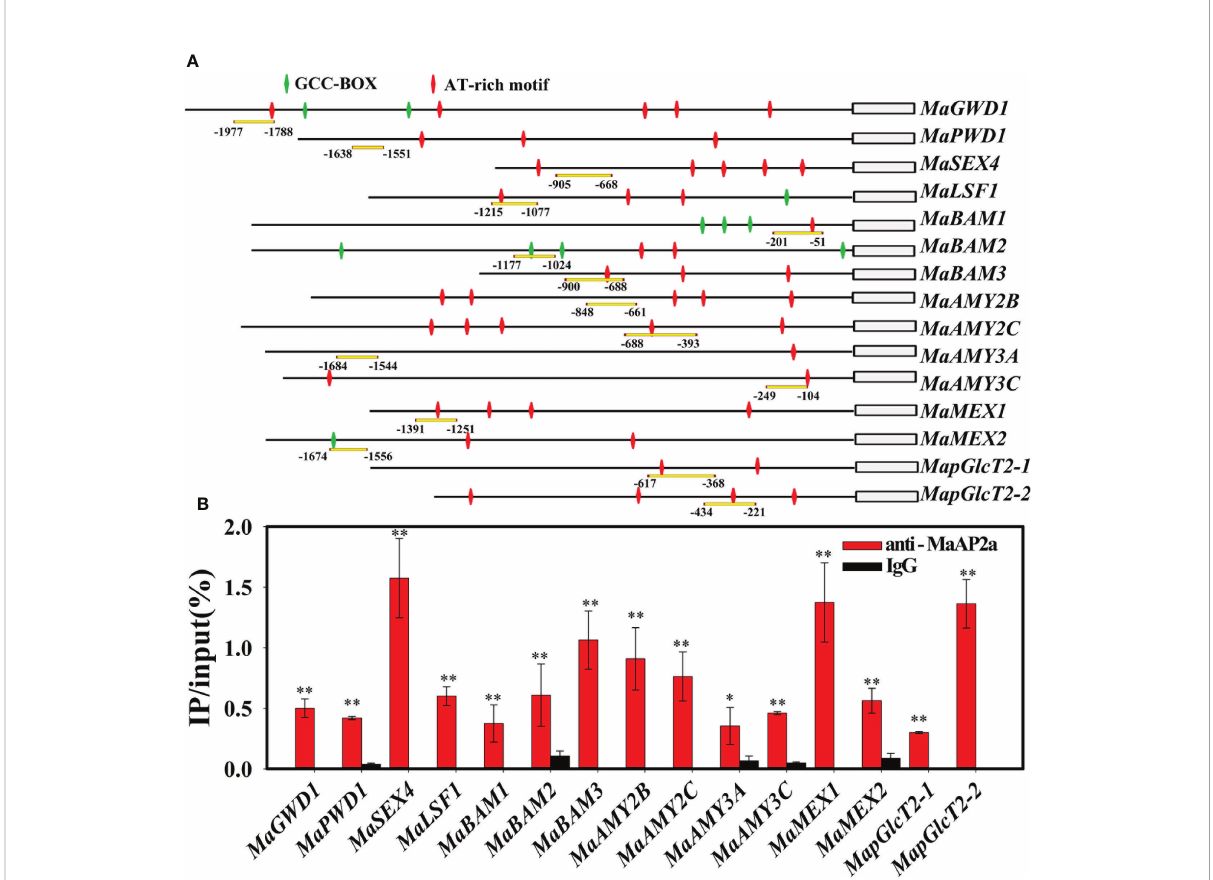
FIGURE 6 MaAP2a binds to the promoters of genes involved in starch degradation in vivo . (A) Schematic representation of selected regions for ChIP-qPCR analyses. Probes selected for the qPCR assay are indicated with yellow underline. GCC-box and AT-rich motifs of the promoters are indicated with green and red diamonds, respectively. (B) ChIP-qPCR assay showing the binding of MaAP2a to the promoters of starch degradation- associated genes. Nucleoprotein and DNA cross-linking complexes were extracted and immunoprecipated with MaAP2a antibody or IgG (negative control). The * and ** indicate signi fi cant differences in p values <0.05 or <0.01,